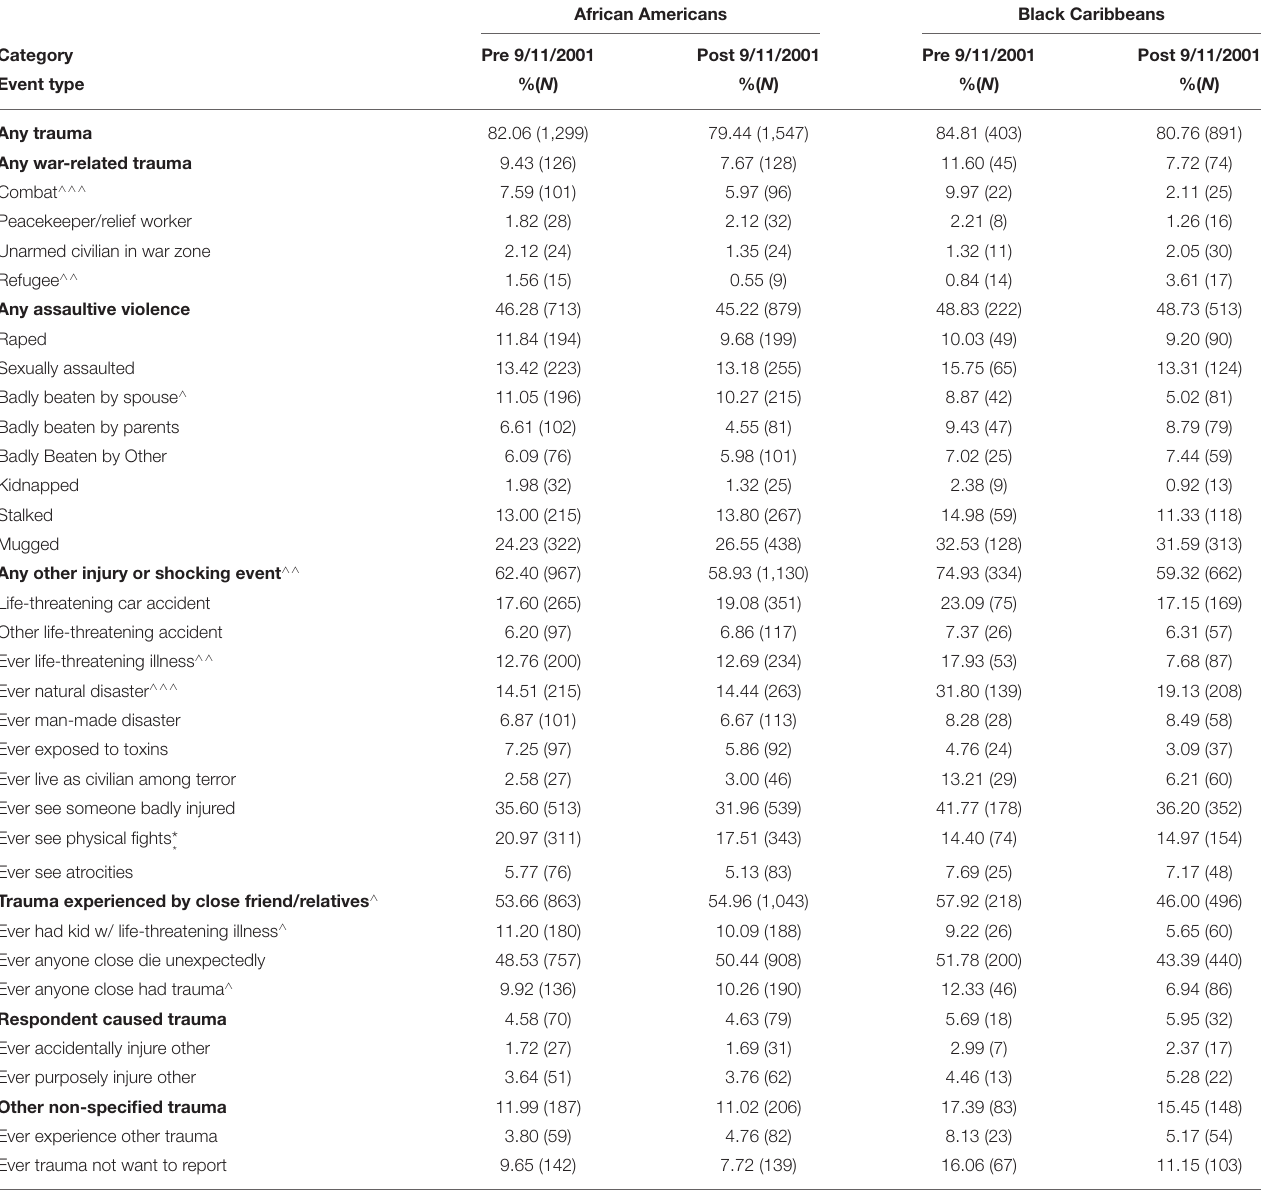
TABLE 2 | Lifetime exposure to potentially traumatic events for African Americans and Black Caribbeans before and after